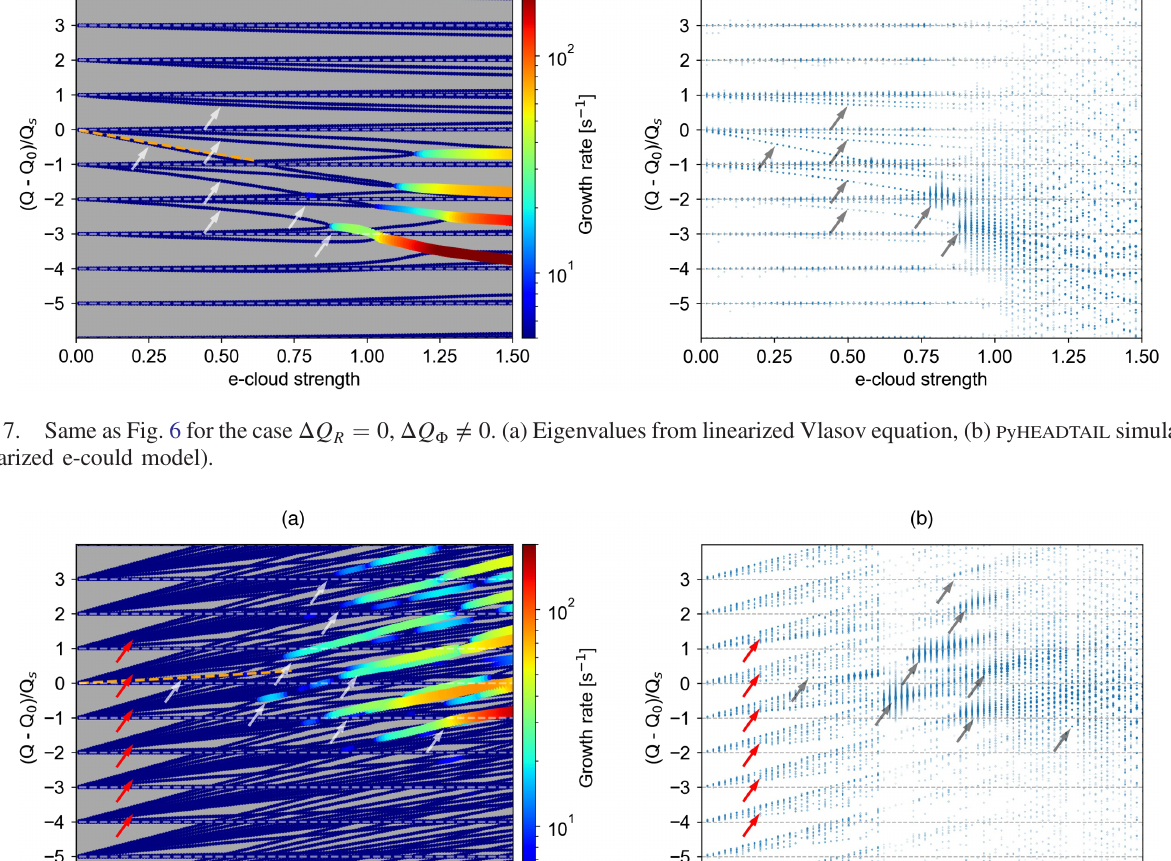
model).FIG. 6. (a) Frequencies of the eigenmodes computed with the Vlasov method for the case Δ Q proportional to the mode ’ s growth rate). (b) Spectrum of the transverse motion for the same configuration, computed using P y HEADTAIL macroparticle simulations with the linearized e-cloud model. The arrows in the plots highlight distinctive features (behavior of certain modes, observation of mode coupling) that are visible with both